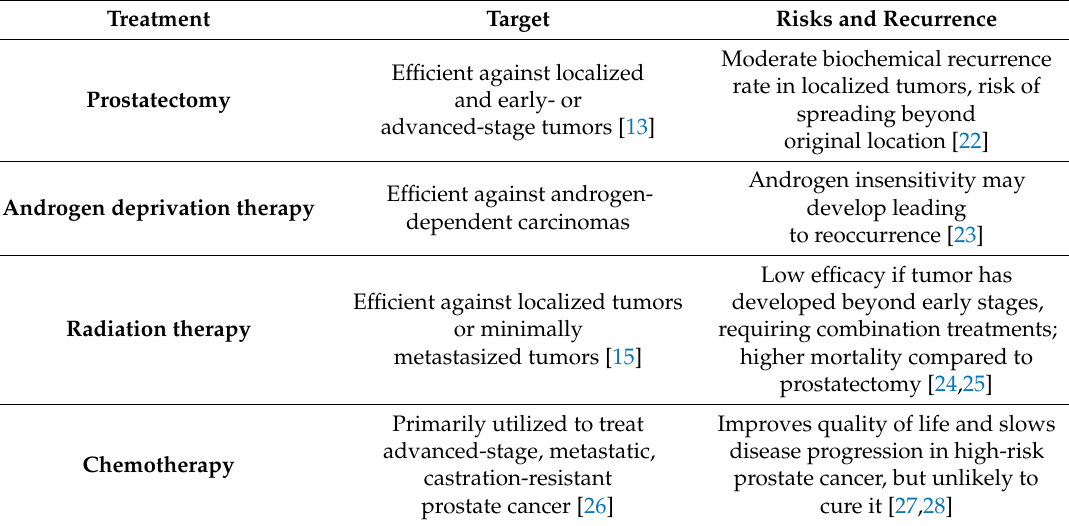
Table 1. Current available treatments for prostate